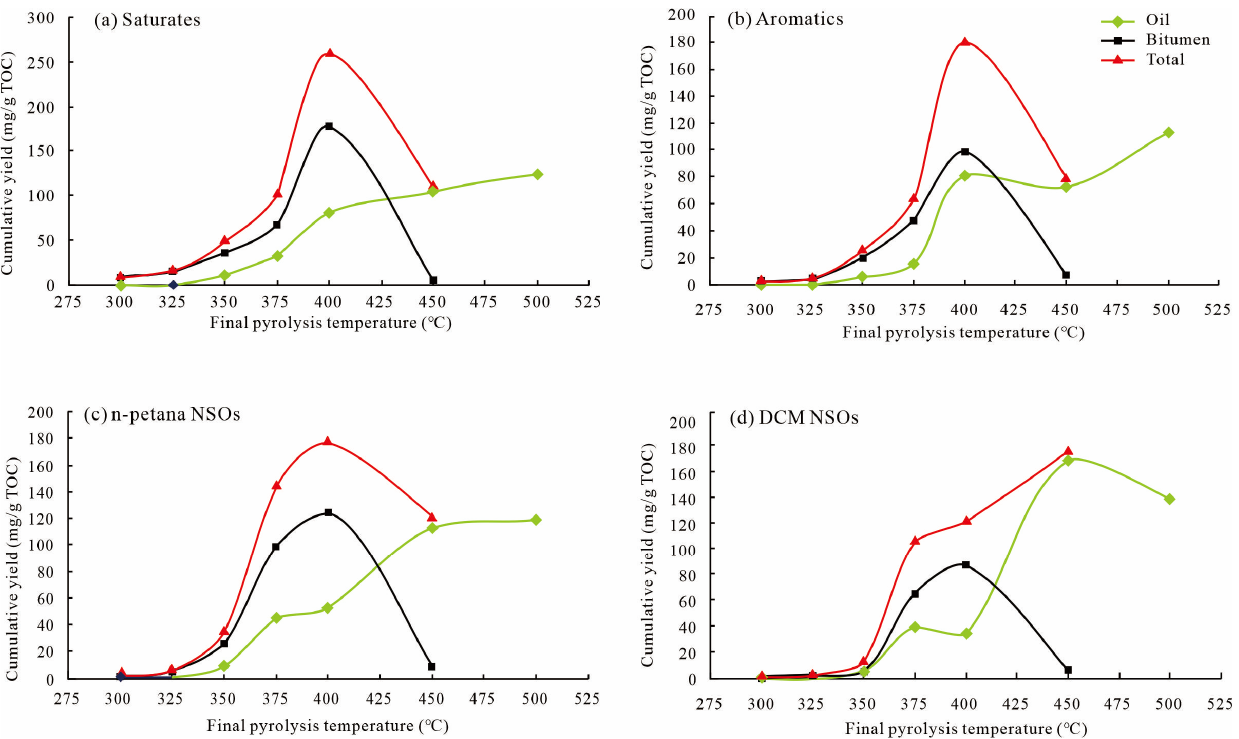
Figure 6. Partitioning of ( a ) saturates, ( b ) aromatics, ( c ) n –pentane NSOs (resins), and ( d ) DCM NSOs (asphaltines) between oil and bitumen.